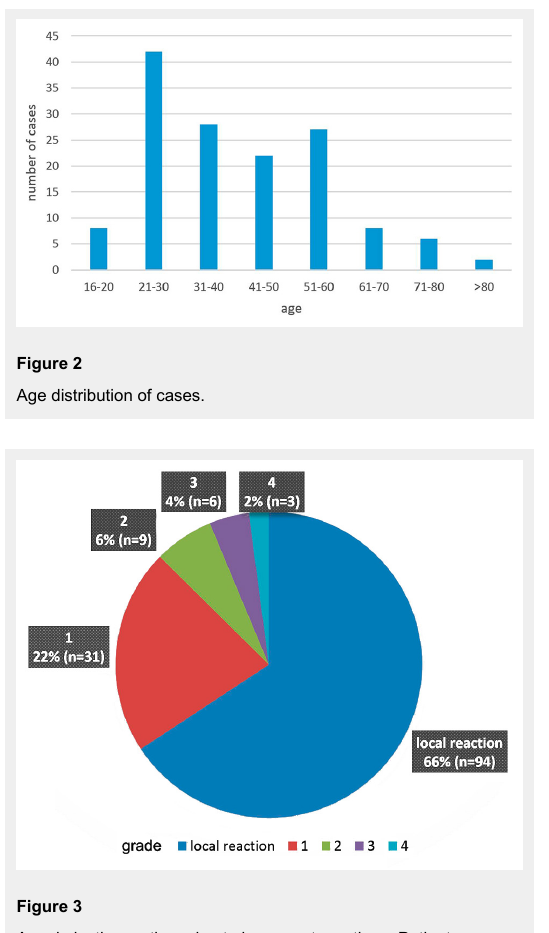
Anaphylactic reactions due to hymenoptera stings. Patients were scored according to Mueller et al [12] into local reactions, and grades I to IV (1–4) anaphylactic